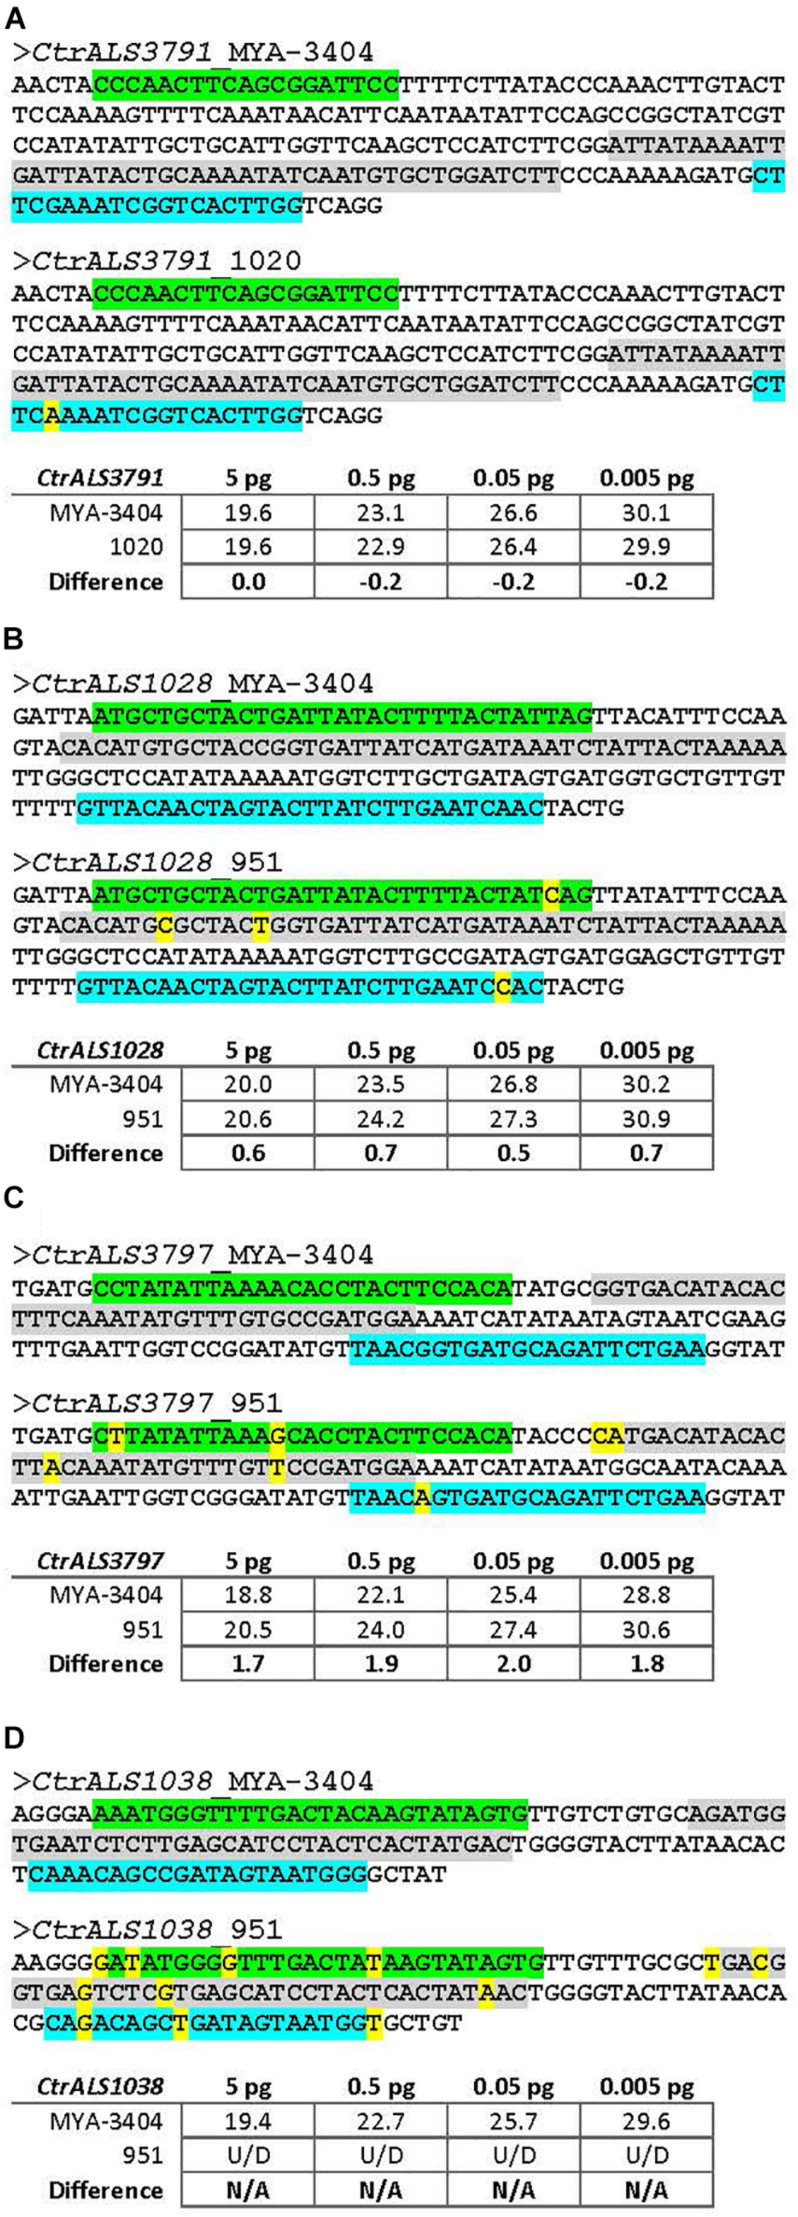
Effect of nucleotide sequence mismatch on TaqMan assay measurement of nucleic acid abundance. TaqMan assays were designed using gene sequences from C. tropicalis strain MYA-3404. Selection of unique target regions that distinguished among genes in the ALS family was the primary consideration in assay design. Sequencing of the 5′ domain of each ALS gene in six other C. tropicalis isolates revealed some mismatches in the TaqMan primer and/or probe sequences. Examples were selected to titrate the effect of an increasing number of mismatches, some in key primer/probe positions. Sequences in each panel were taken from Supplementary File S3. The forward primer was highlighted in green, reverse primer in blue, and probe in gray. Mismatches were noted with yellow color. Target sequences in each strain examined were PCR amplified, cloned, and Sanger sequence verified to ensure the mismatches were present. Cloned DNA was purified, diluted, and used in the assays reported here. (A) The sequence of the 5′ domain of CtrALS3791 in strain 1020 showed a single nucleotide mismatch in the middle of the reverse primer. Ct values from TaqMan assays with 10-fold dilutions of cloned construct showed almost an equal ability for the assay to detect each strain (e.g., no difference for 5 pg DNA and negligible differences for subsequent dilutions). (B)
C. tropicalis strain 951 showed one to two mismatches each in the primer and probe sequences for gene CtrALS1028. Ct values suggested that detection of strain 951 lagged approximately 0.6 cycle behind detection of strain MYA-3404, providing an underestimate of DNA abundance. (C) Increasing numbers of mismatches between primer and probe sequences resulted in greater underestimates of DNA abundance for strain 951, this time in CtrALS3797 where nearly a two-cycle difference in Ct was observed. (D) Mismatches for CtrALS1038 in strain 951 were so marked that the TaqMan assay was unable to detect genomic DNA, even at the highest concentration. These data provide the foundation necessary to adapt use of the TaqMan assays to C. tropicalis isolates in which primer and probe mismatches may exist.